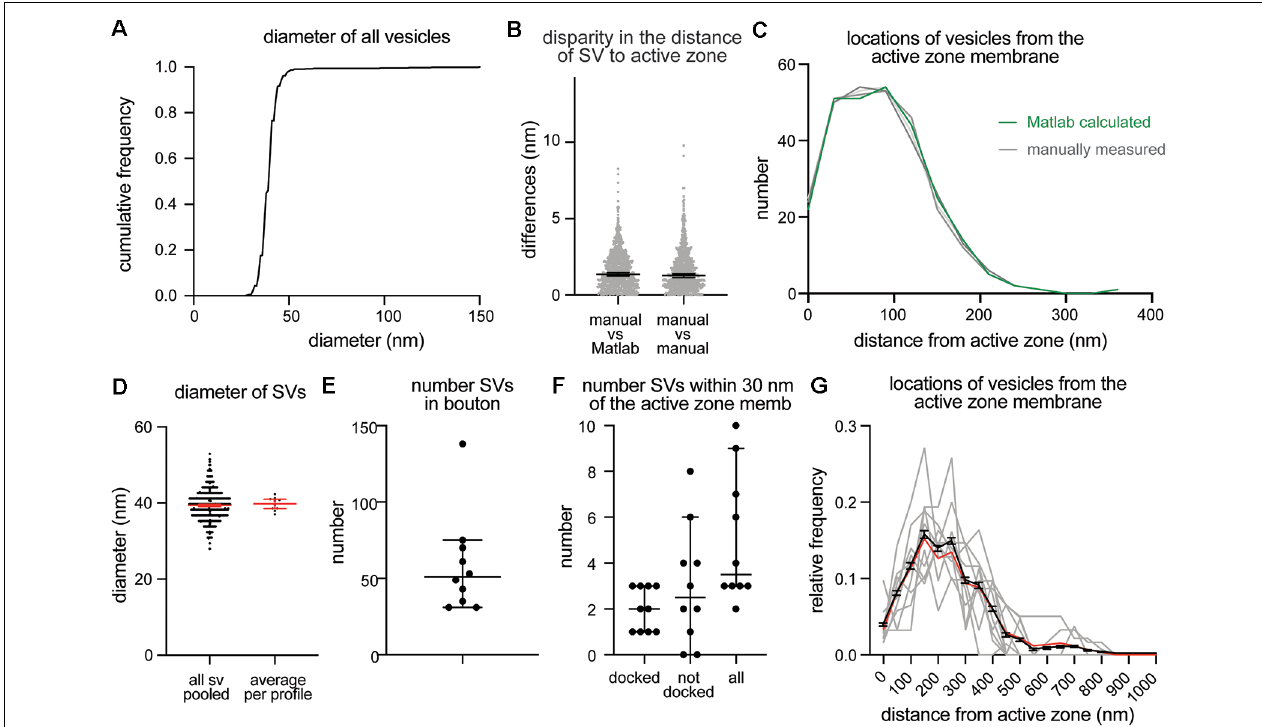
FIGURE 3 | Example plots that can be readily generated with the synapsEM. (A) A cumulative plot showing the diameter of all vesicles annotated from 10 sample images used in this study. A total of 590 vesicles are annotated. (B) A scatter plot showing the disparity in distances of vesicles to the active zone membrane between the Matlab calculated and manually measured (left) or among three manually measured (right). Each dot = one measurement. The medians are 1.4 nm and 1.3 nm, respectively, ( p = 0.8, unpaired t -test). (C) A plot showing the distribution of vesicle distances from the active zone membrane. No difference is observed between the Matlab calculated and manually measured ( p > 0.99, Kruskal–Wallis test with Dunn’s multiple comparison test). (D) A plot showing the diameter of synaptic vesicles, averaged from all vesicles pooled (left, 39.6 ± 0.2 nm, mean ± SEM) and means of each profile (right, 40.1 ± 0.6 nm, mean ± SEM). (E) A plot showing the number of vesicles in the terminal. Each dot = the number in each profile. (F) A plot showing the number of vesicles docked or tethered at the active zone or all vesicles within 30 nm of the active zone membrane. Each dot = the number in each profile. (G) A plot showing the distribution of synaptic vesicle distances to the active zone. Gray lines = the normalized distance distribution from each profile. Black line = average from 10 profiles. Red line = the normalized abundance from the pooled